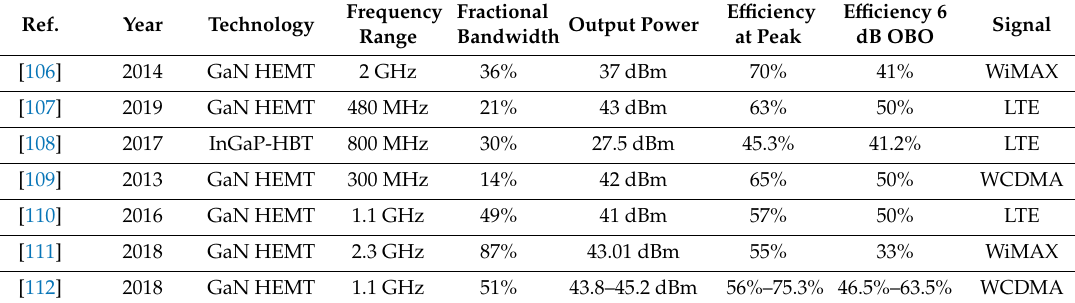
Table 8. Performance summary of broadband Doherty